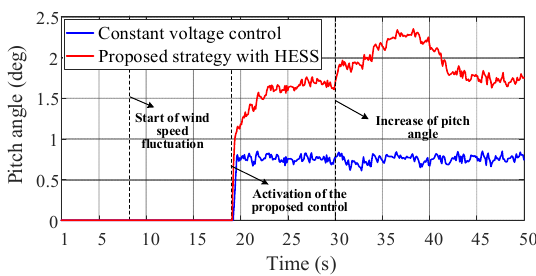
Figure 24. The pitch angle of the DFIG in case II.